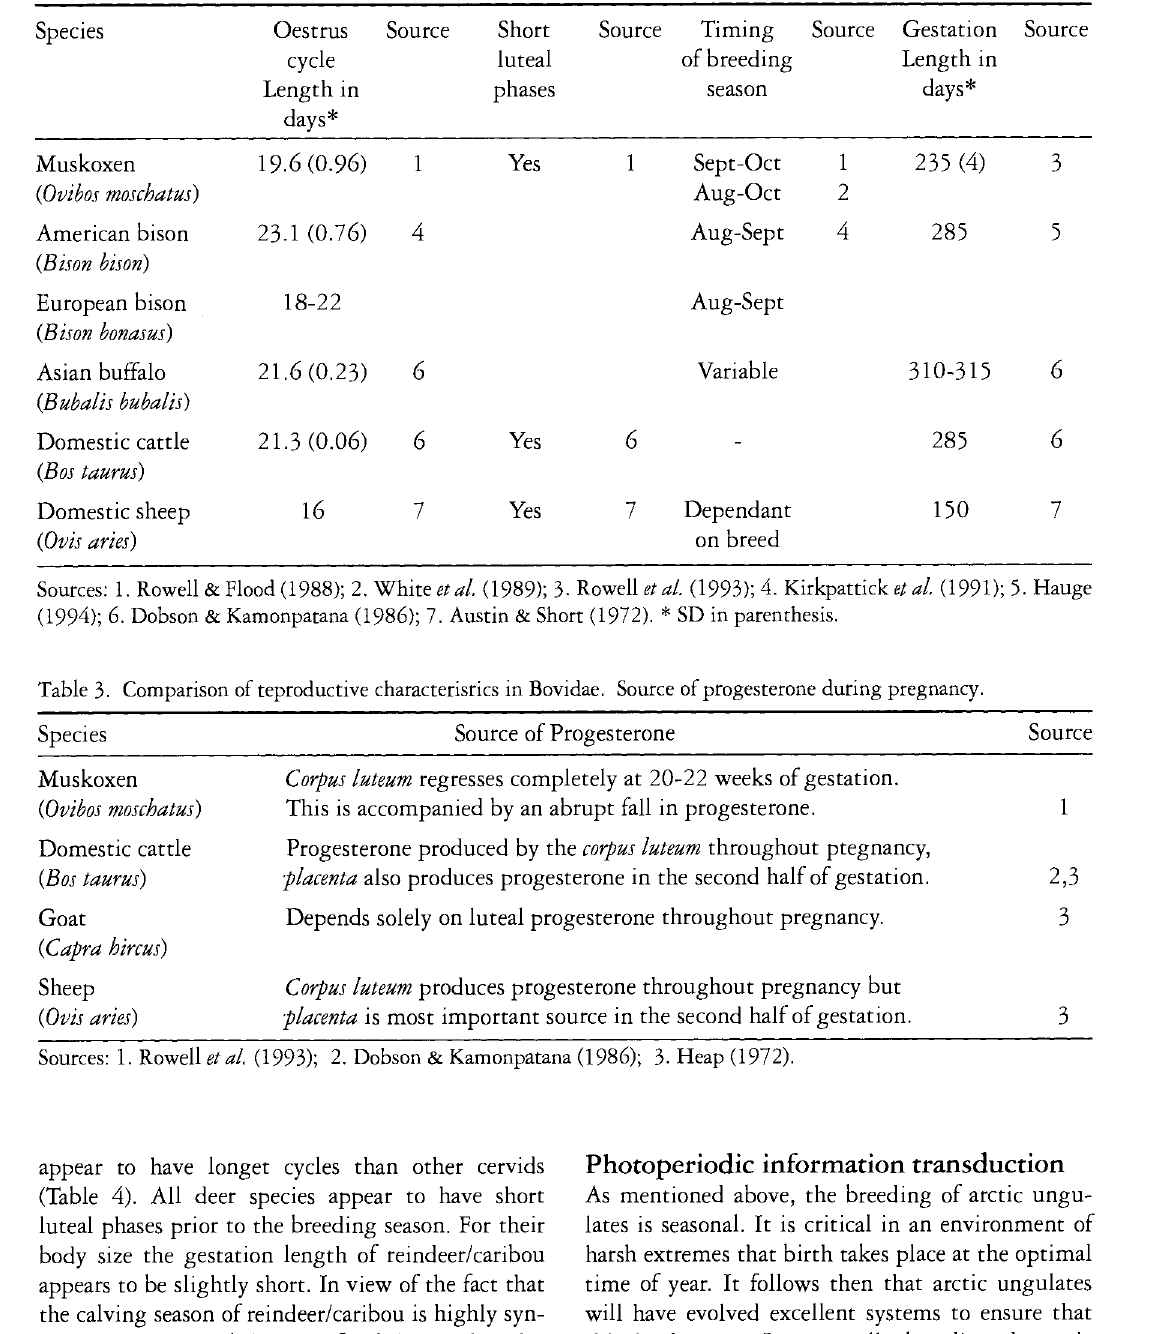
Table 3. Comparison of teproductive characterisrics in Bovidae. Source of progesterone during pregnancy. Species Source of Progesterone